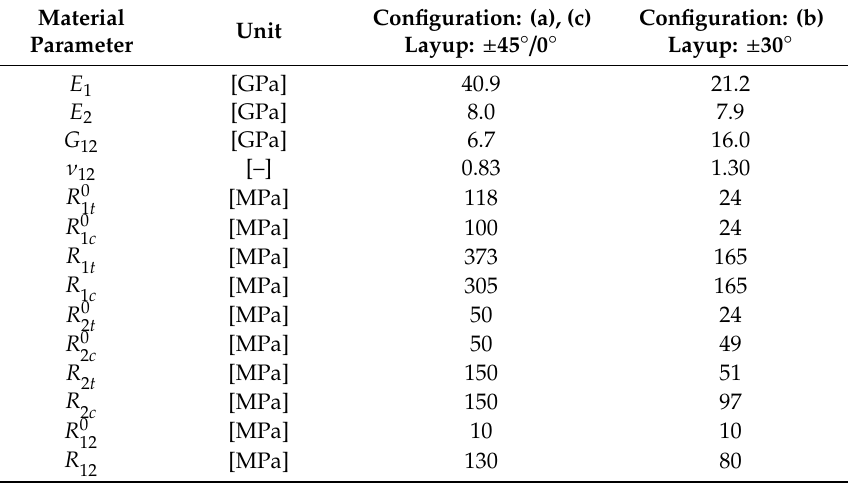
Table 1. Engineering constants, onset of damage and